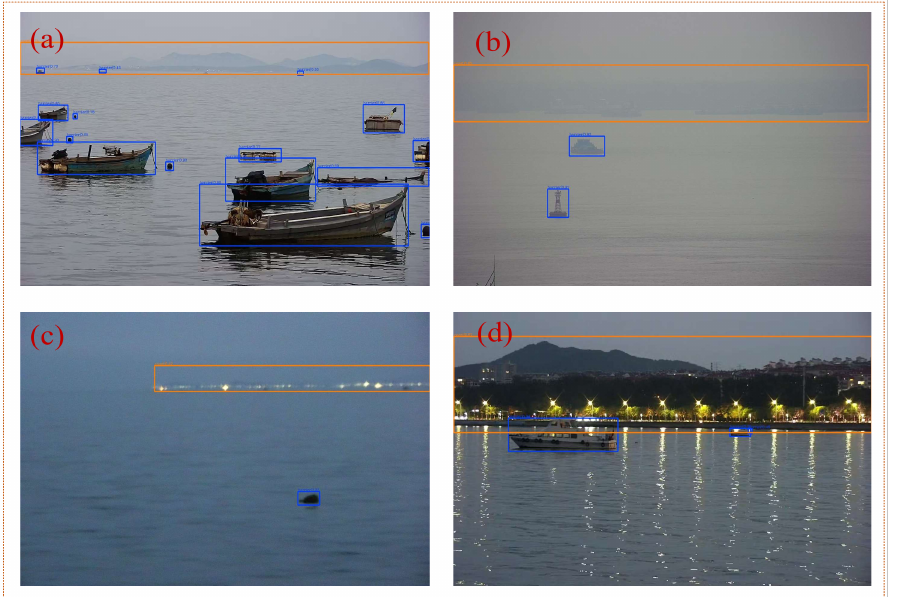
Figure 15. Detection results in real maritime scenarios. ( a ) Dense-target scene. ( b ) Sea fog scene. ( c ) dawn scence. ( d ) night